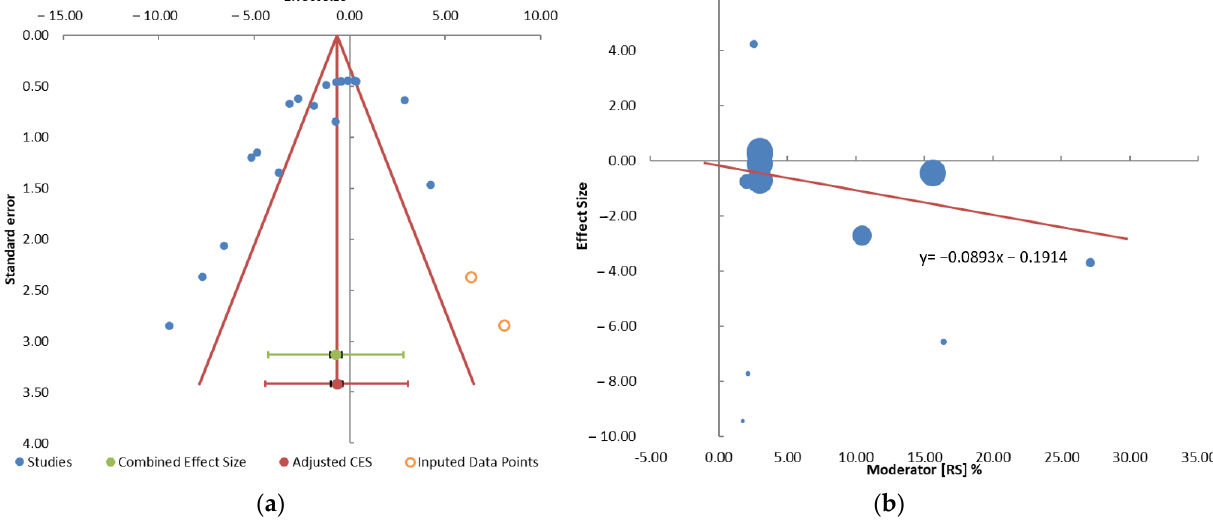
Figure 5. ( a ) The funnel plot of the effect of differing resistant starch content in carbohydrate foods-to-GI; ( b ) the meta- regression between resistant starch content (%) and effect size.